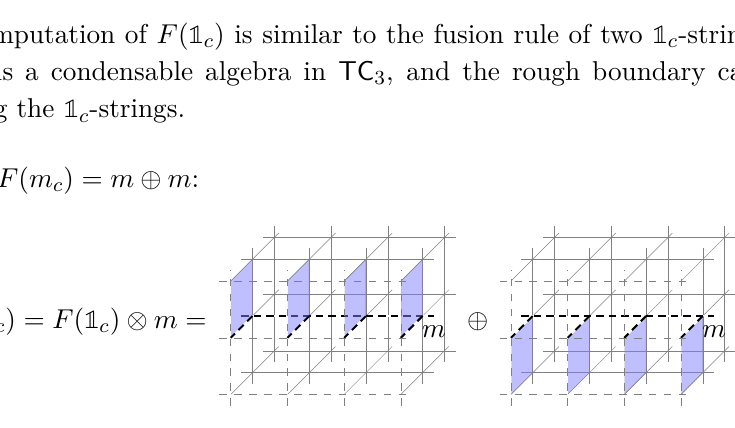
Figure 27. The 1 c -strings are condensed on the rough boundary. We have F ( 1 c ) = 1 ⊕ 1